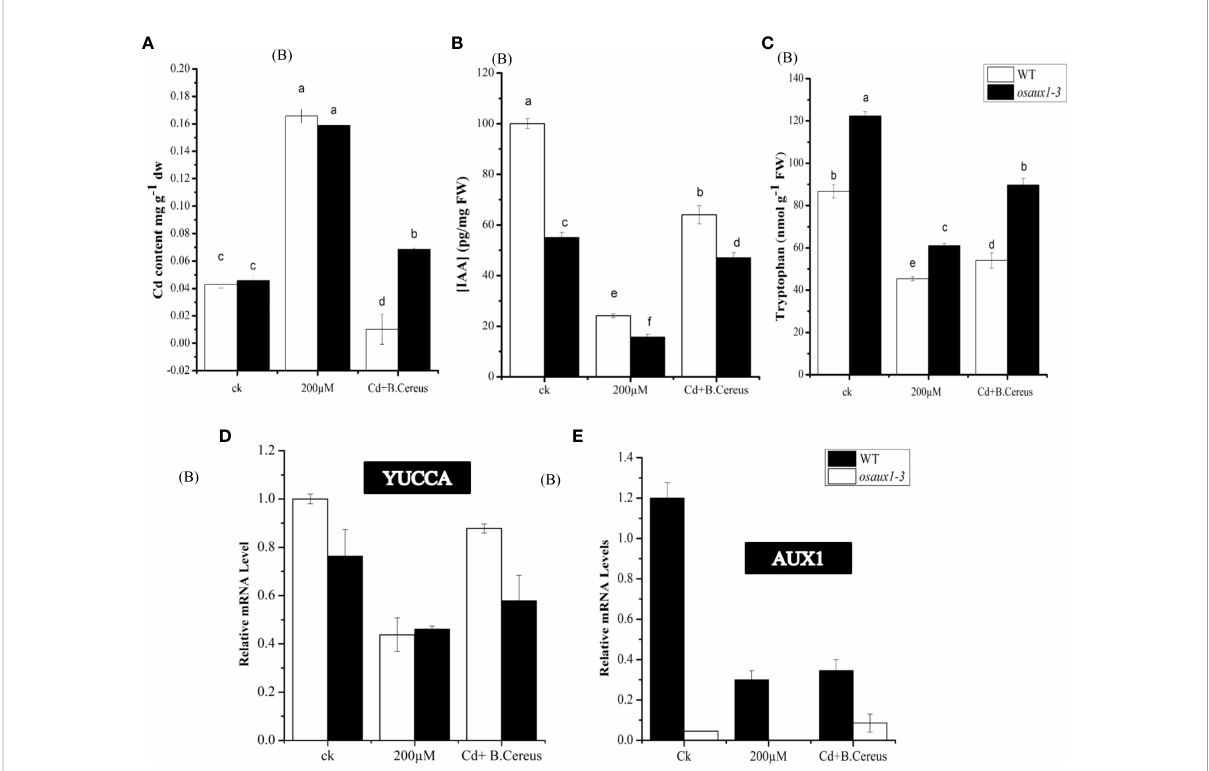
FIGURE 6 Effect of Cd on IAA and tryptophan content in wild-type and osaux1-3 content. (A) Cadmium content was measured in root (B) , indole 3-acetic acid (IAA) (C) , and tryptophan content in WT and osaux1-3 . Rice seedlings were inoculated with or without (B) cereus and 200 µM CdCl 2 for 4 days in three biological repeats. (D, E) Relative mRNA levels of YUCCA and AUX1 in roots of wild-type and osaux1-3 after 3 days of treatment with 200 µM CdCl 2 and (B) cereus . Three biological repeats were included for quantitative RT-PCR analysis. Lowercase letters indicate signi fi cant differences between means, determined using Duncan ’ s multiple range mean